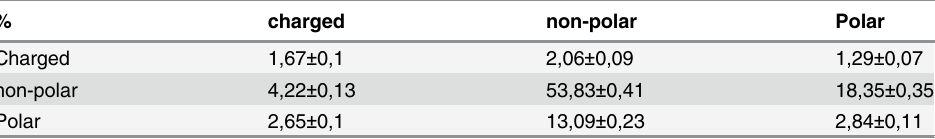
Table 1. Relative frequency of the various type of amino acid substitutions within the TM regions associated with polymorphisms. % charged non-polar Polar Charged 1,67 ± 0,1 2,06 ± 0,09 1,29 ± 0,07 non-polar 4,22 ± 0,13